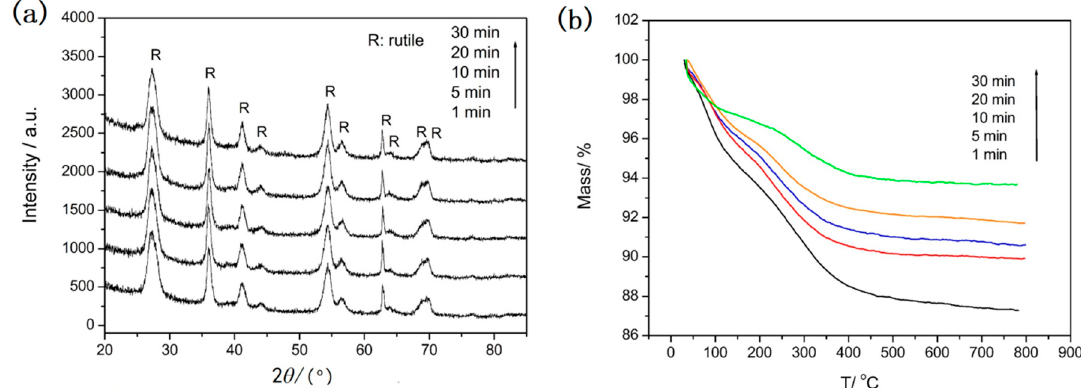
Figure 4. XRD patterns ( a ) and TG curves ( b ) of the TiO 2 samples synthesized at 135 °C under different microwave irradiation time.